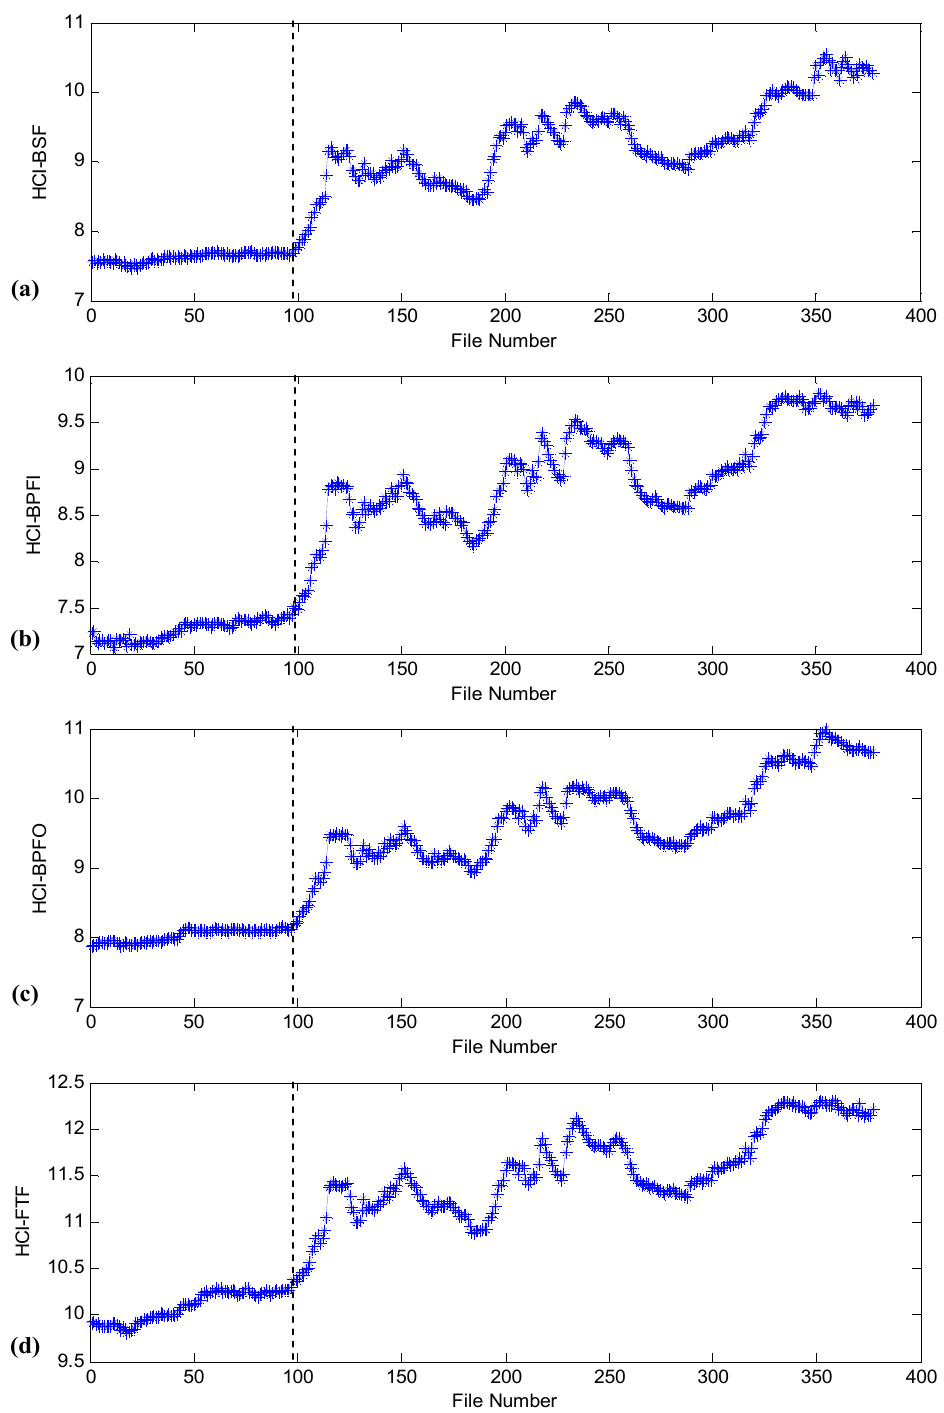
Figure 7. Fan bearing health assessment using the proposed HCI with different